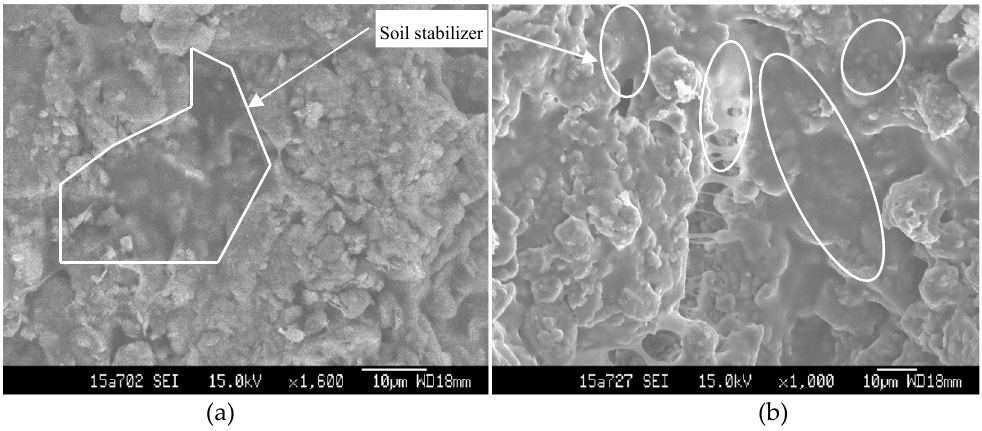
Figure 10. SEM images of the aggregate surfaces: ( a ) treated with 2% ADNB; ( b ) treated with 5% ADNB.